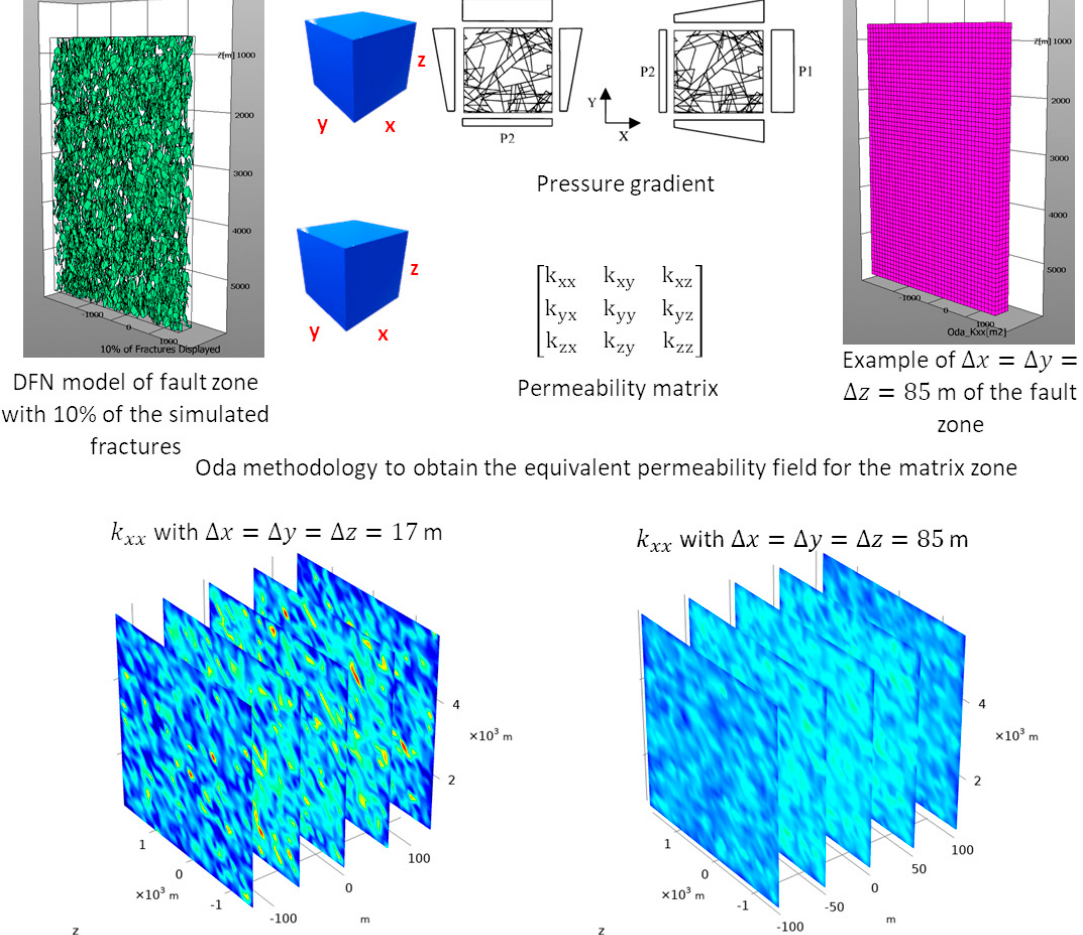
Figure 7. Oda methodology [27] to calculate the equivalent permeability field and its sensitivity to the two different mesh sizes (17 and 85 m, respectively). Upper left: first, a stochastic DFN of the fault zone and host rock is created based on the fracture network characteristics; Upper middle: then, using the Oda approach, a permeability field is calculated for each cell of a given grid (upper right) separately. The bottom panels show the heterogeneous permeability field for the matrix zone for two different mesh sizes for the equivalent permeability estimation (lower right and lower left). The unit of permeability is m 2 .